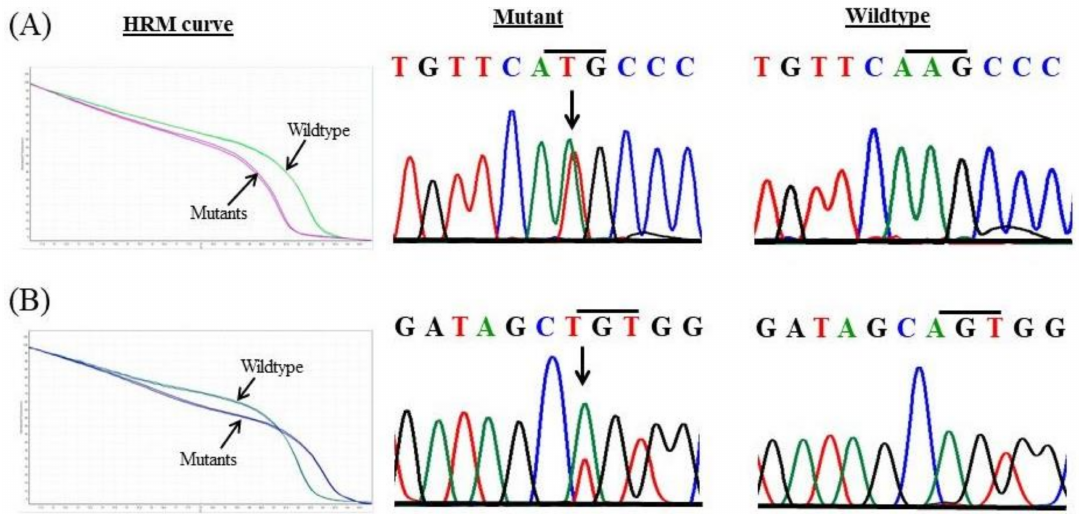
Figure 2. Novel mutations in EPAS1 identifies in phaeochromocytomas and paragangliomas. Comparison of high-resolution melt (HRM) curve analysis and Sanger sequencing of the mutations identified in patients with phaeochromocytomas / paragangliomas. ( A ) Representative HRM curve and chromatograph for the missense mutation c.1091A > T (p.Lys364Met). ( B ) Representative HRM curve and chromatograph for the substitutional mutation c.1129A > T (p.Ser377Cys). Table 2. Correlation of EPAS1 mutations with clinicopathological features of patients with phaeochromocytoma and